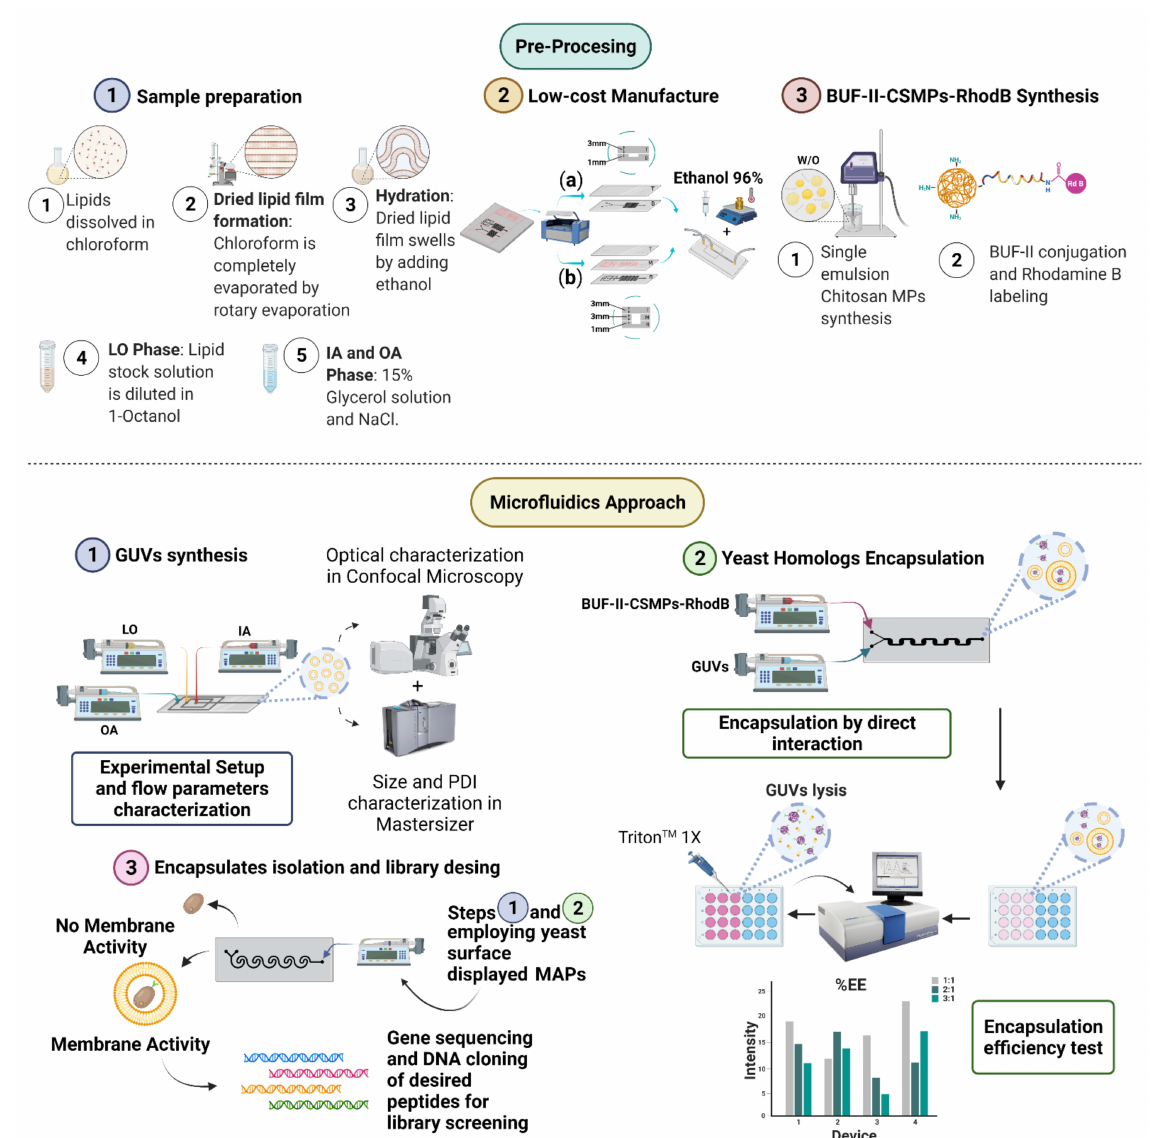
Figure 1. Schematic of Membrane-active Peptides (MAPs) library screening workflow. Pre-Processing stage steps: (1) Sample preparation of inner and outer aqueous phase and dried lipid film hydration for lipid-carrying organic phase preparation, (2) Low-cost laser cutting-based manufacturing technique for two- and three-layer devices, and (3) Synthesis of BUF-II-CSMPs-RhodB conjugates. Microfluidics approach steps: (1) Giant Unilamellar Vesicles (GUVs) synthesis based on octanol-assisted double emulsion templates, (2) Yeast homologues encapsulation by mixing-controlled direct interaction, finally (3) Encapsulates isolation and MAPs non-rational library